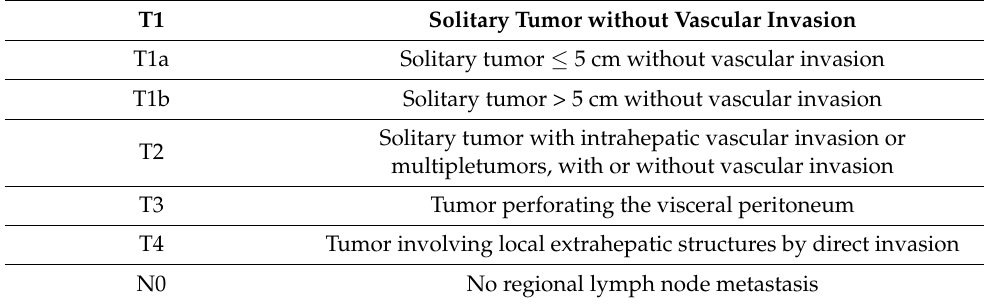
Table 1. The AJCC 8th edition Staging System for